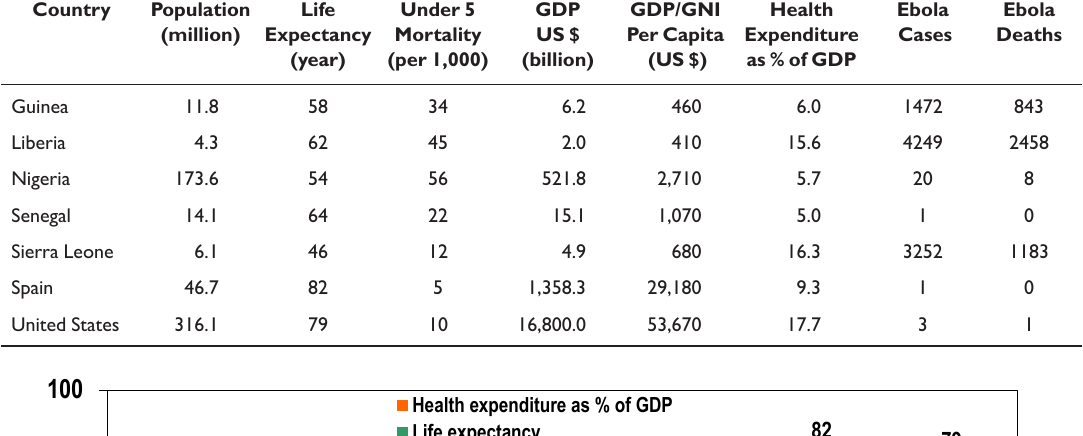
Table 1. Health Expenditure, GDP, and Selected Health Indicators in Ebola Affected Countries Country